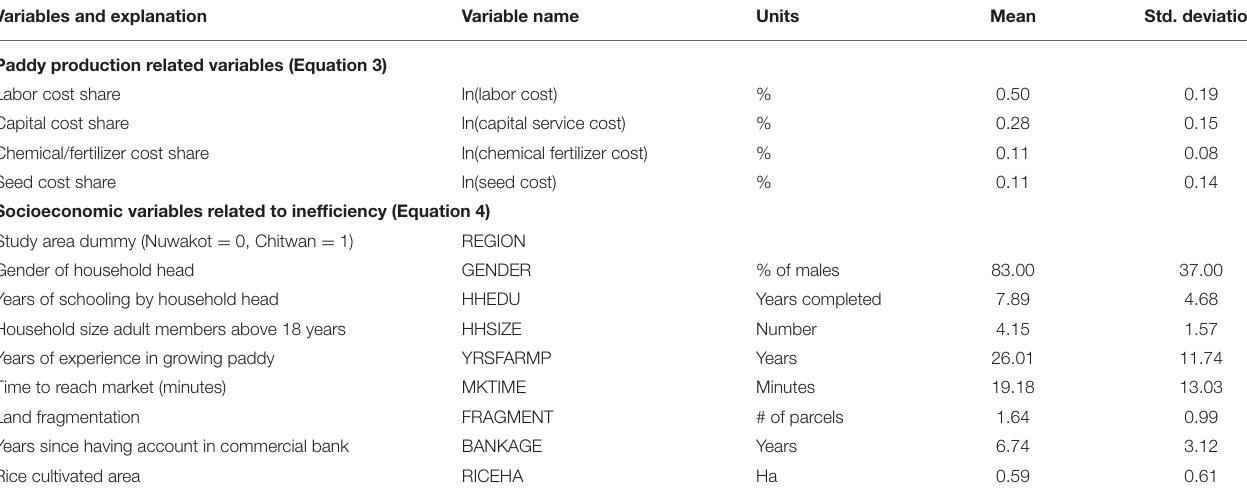
TABLE 10 | Descriptive statistics ( n = 197).